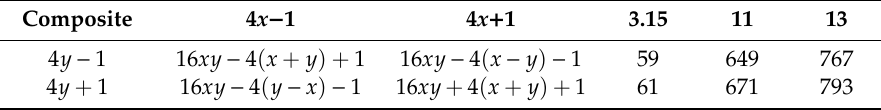
Table 1. Possible composite constructs using Pythagorean and Gaussian